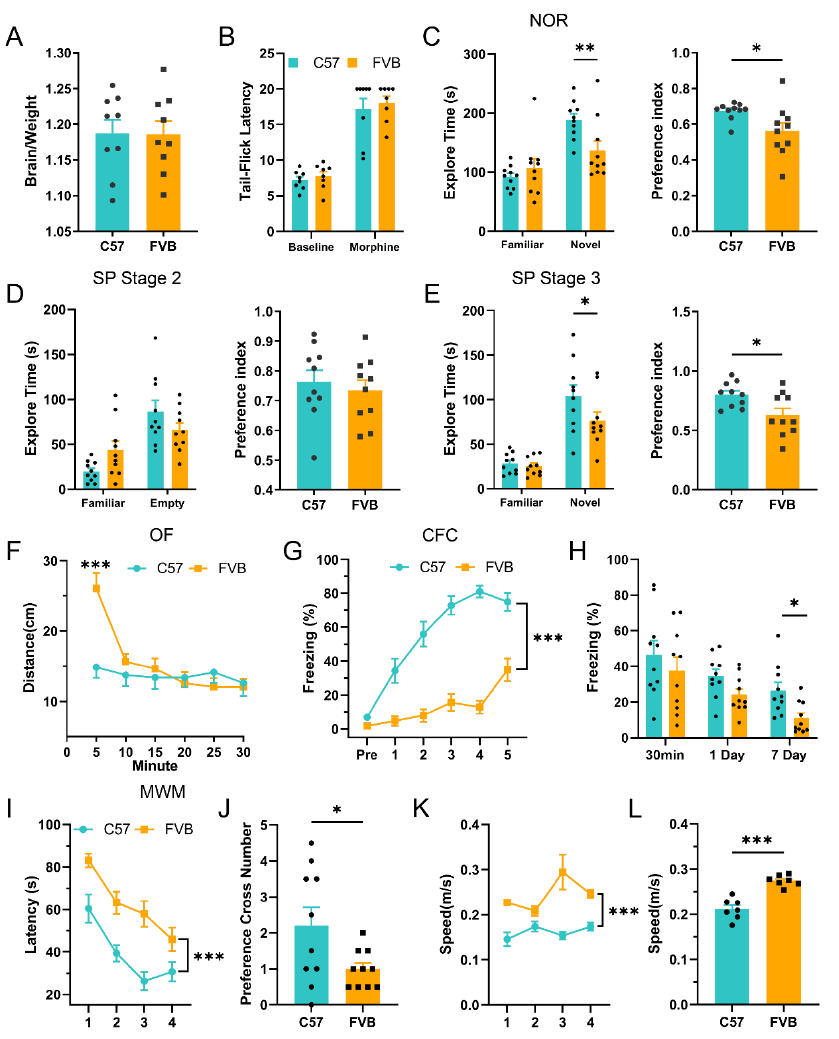
Figure 2. Normal learning ability was poor in FVB mice. ( A ). The weight percent ratio of brain to body in C57 and FVB mice (n = 9, unpaired t -test). ( B ). The tail flick test in C57 and FVB mice (n = 9, two-way ANOVA), baseline and 30 min after morphine. ( C ). Novel object recognition (NOR) test in C57 and FVB mice shows the time spent with a familiar and a novel object (n = 10, two-way ANOVA, t -test). (Left): Exploration time. (Right): Preference index. ( D ). Social preference test (SP) stage 2 shows the exploration time (left) and preference index (right) for a familiar mouse and an empty cage in C57 and FVB mice (n = 10, two-way ANOVA, t -test). ( E ). Social preference test stage 3 compares the exploration time (left) and preference index (right) for a novel mouse and familiar mouse in C57 and FVB mice (two-way ANOVA, t -test). ( F ). The open field (OF) test collected the distance of motion every five minutes over 30 min between C57 and FVB mice (n = 10, RM two-way ANOVA). ( G ). Learning curve during contextual fear conditioning (CFC) training (n = 10, RM two-way ANOVA). ( H ). Contextual fear conditioning memory test at 30 min, 1 day, and 7 days in C57 and FVB mice (n = 10, two-way ANOVA). ( I ). Learning curve during Morris water maze training (n = 10, two-way ANOVA). ( J ). The platform cross number in the Morris water maze memory test between C57 and FVB mice (n = 10, t -test). ( K ). Swimming speed during Morris water maze training (n = 7, two-way ANOVA). ( L ). Swimming speed Morris water maze memory test between C57 and FVB mice (n = 7, t -test). * p < 0.05, ** p < 0.001, *** p < 0.001, Mean ± SEM.